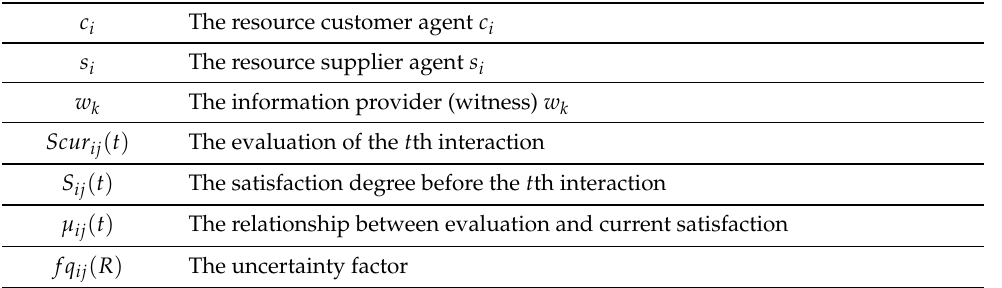
Figure 1. Trust estimation processes. Table 2. Explanation of main